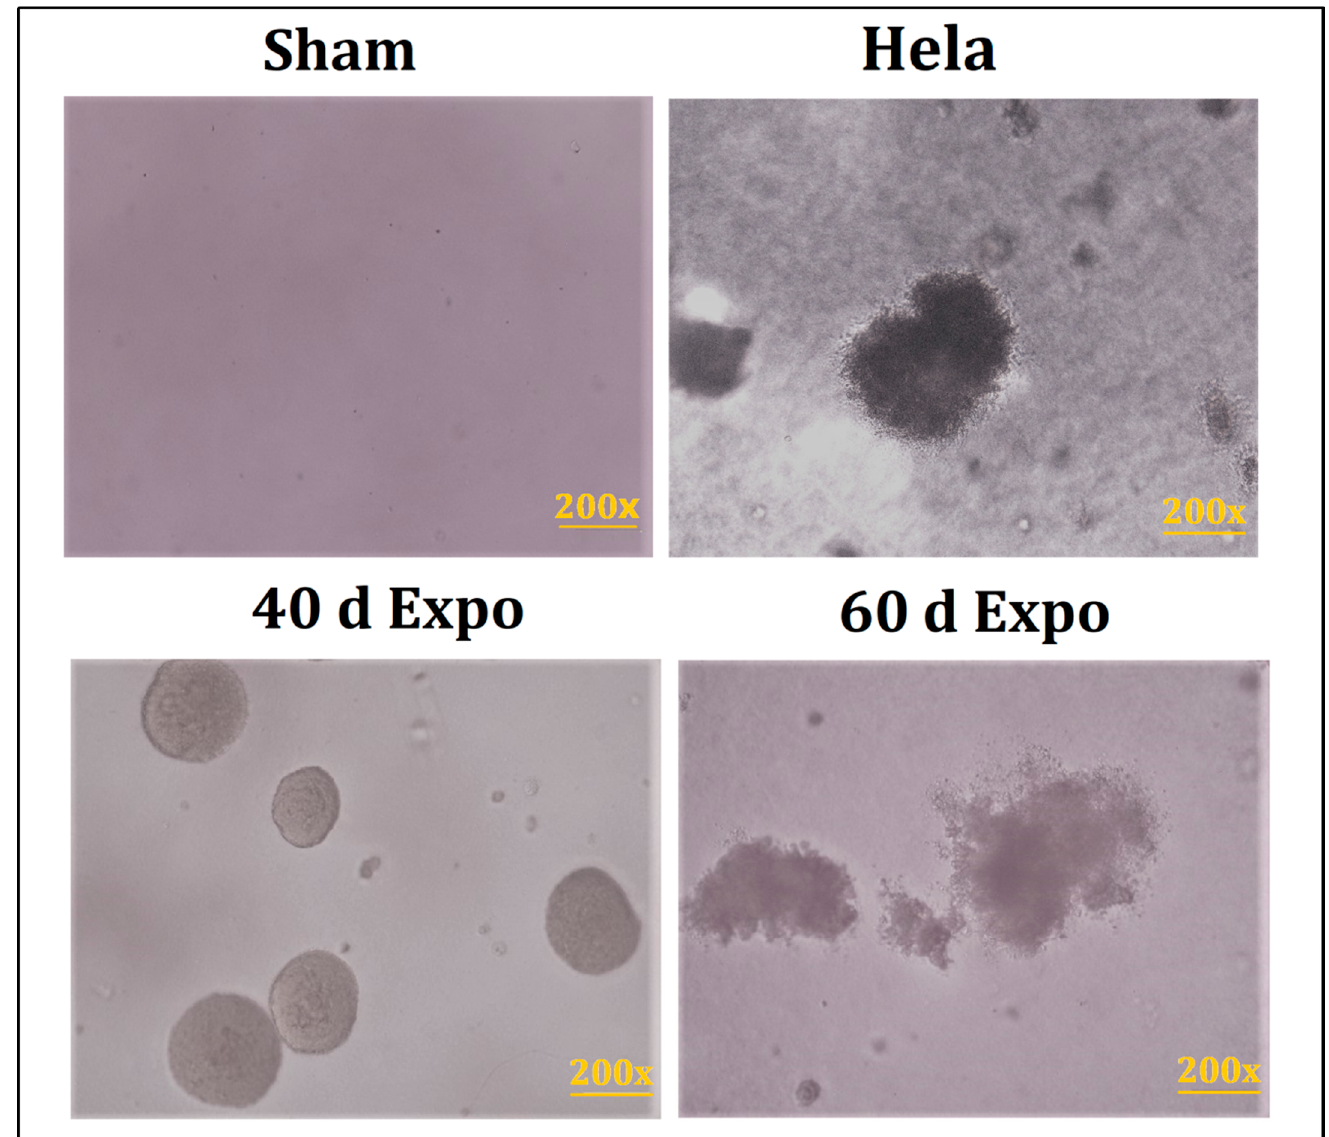
Figure 5. Representative images of clone formation in soft agar . Visible clones were observed in 40-day and 60-day expo Balb/c-3T3 cells. No clones were found in sham cells. HeLa cells were used as the positive control.